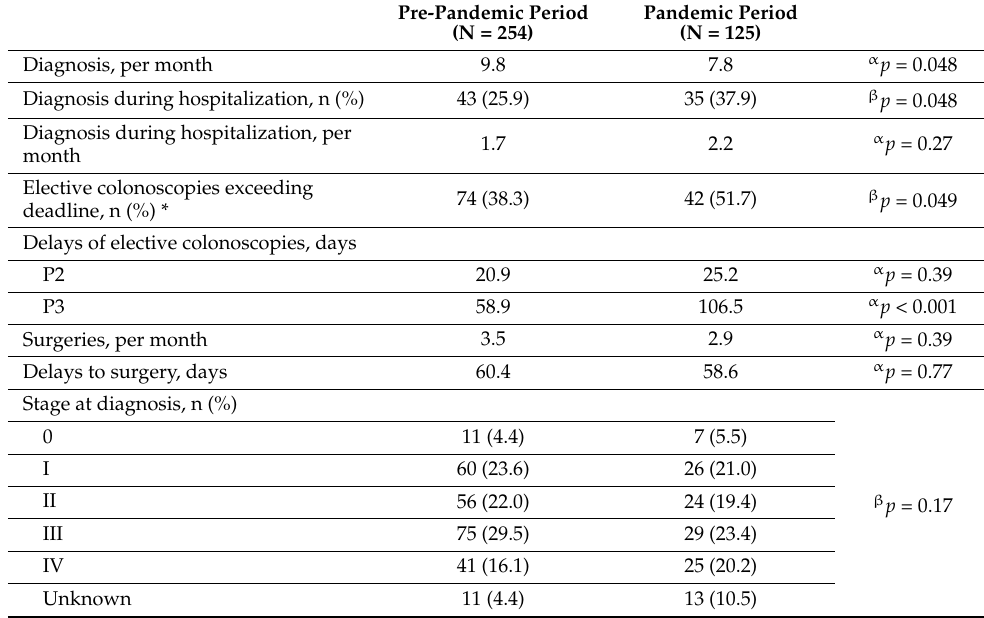
Table 2. The impact of the COVID-19 pandemic on colonoscopies, surgeries and staging of CRC. Pre-Pandemic Period Pandemic Period (N = 254) (N = 125) Diagnosis, per month 9.8 7.8 α p = 0.048 Diagnosis during hospitalization, n (%) 43 (25.9) 35 (37.9) β p = 0.048 Diagnosis during hospitalization, per 1.7 2.2 α p = 0.27 month Elective colonoscopies exceeding 74 (38.3) 42 (51.7) β p = 0.049 deadline, n (%) * Delays of elective colonoscopies, days P2 20.9 25.2 α p = 0.39 58.9 106.5 α p < 0.001 Surgeries, per month 3.5 2.9 α p = 0.39 Delays to surgery, days 60.4 58.6 α p =